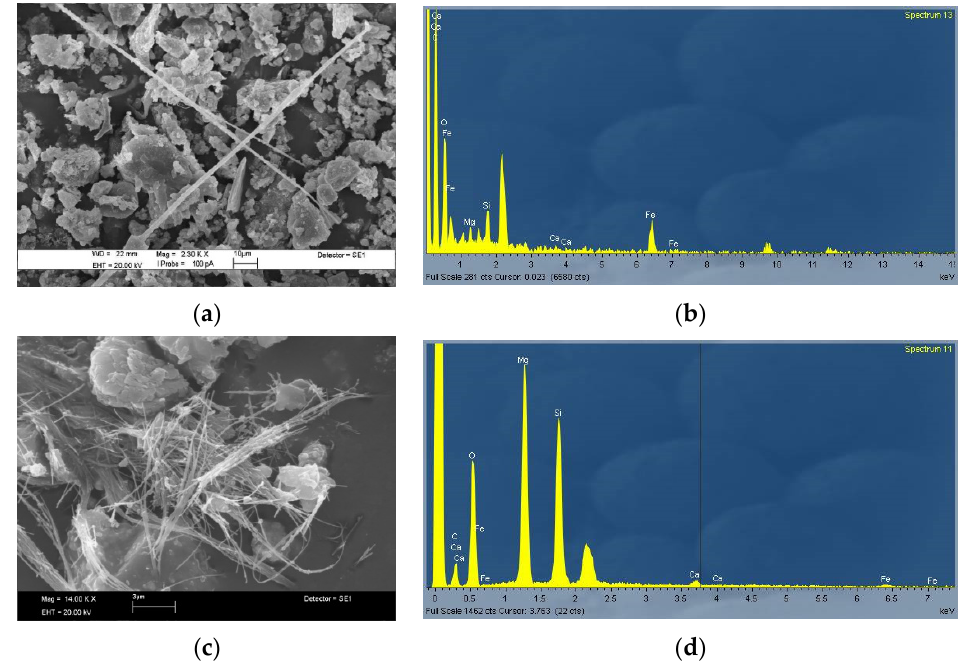
Figure 8. An example of SEM image of amosite ( a ) and chrysotile ( c ) fibers in settled dust samples collected in building A, with friable ACMs, and in a storage warehouse with non-friable ACMs, respectively. Related EDS spectra, (( b , d ), respectively) are also shown.